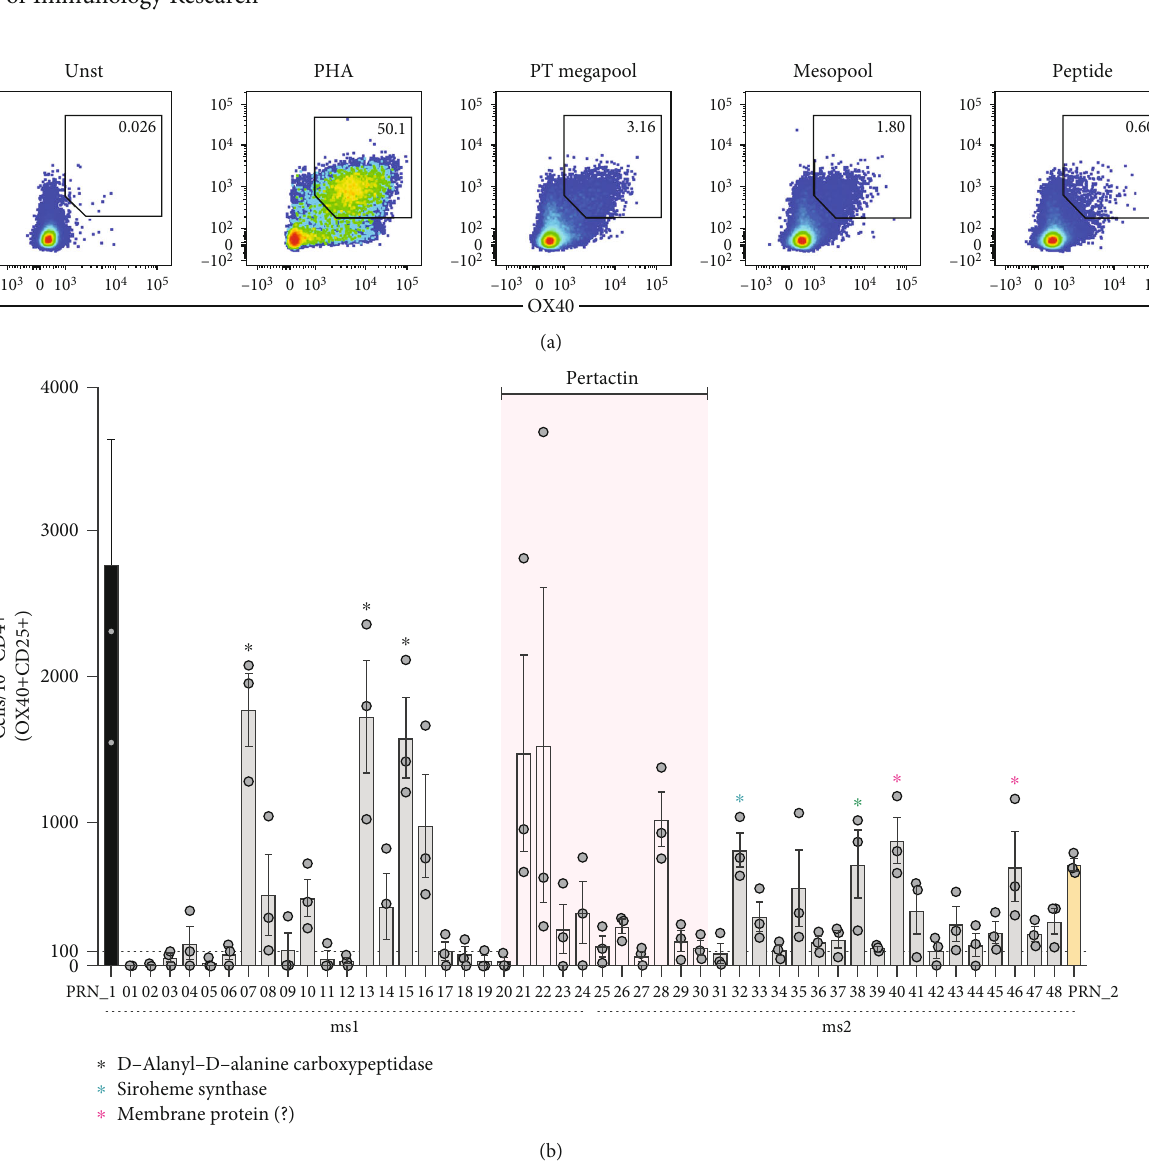
Figure 6: Ex vivo AIM assay can reproducibly detect signals down to the peptide level. (a) Representative fl ow cytometry plots of CD25 +OX40+ upregulation by CD4+ T cells in cells left unstimulated (Unst) or stimulated with pools of peptides (PT-megapool ( n = 132 peptides) or mesopool ( n = 24 peptides)) or individual peptides as well as PHA as a positive control. (b) % of BP-speci fi c CD4+ memory T cells for each individual peptide ( n = 48 ) deconvoluted from 2 contiguous positive MSs (PRN_1 (ms1, n = 24 ) and PRN_2 (ms2, n = 24 )) containing among others, peptides ( n = 10 ) from the known antigen pertactin (PRN; pink area) as measured by AIM assay. Each dot represents an independent technical replicate of the same donor performed on a di ff erent day. A representative donor is shown. Data are expressed as mean ± SEM . The names of the all the antigens encompassing the group of peptides whose responses were signi fi cant are